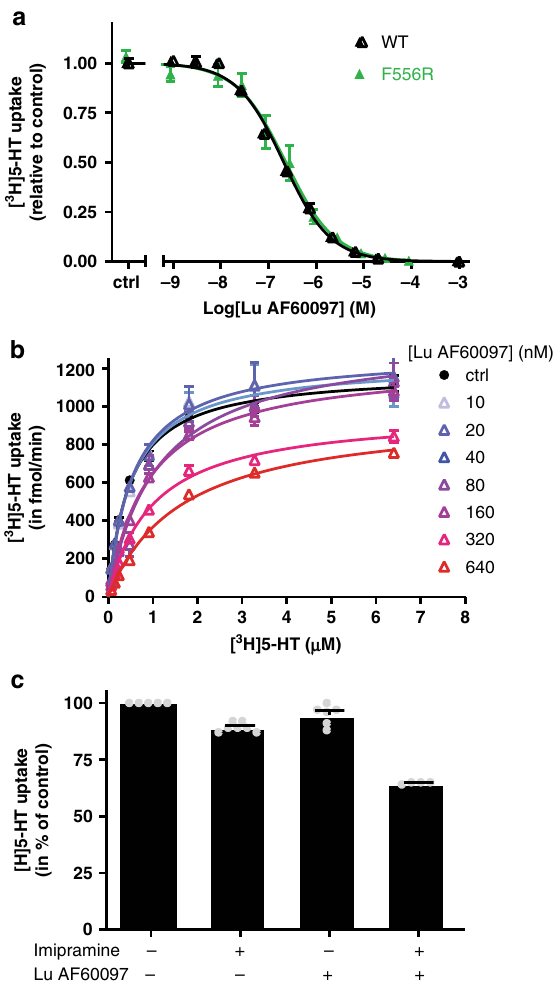
Fig. 5 Pharmacologic properties of Lu AF60097 binding to SERT. a Inhibition of [ 3 H]5-HT uptake by Lu AF60097 in SERT WT and F556R.